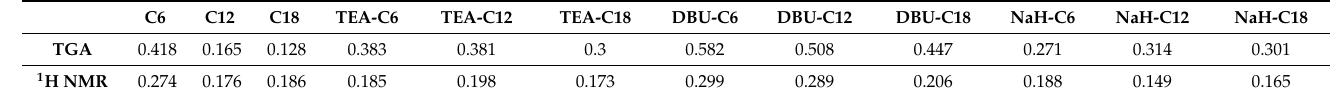
Table 2. Silica silanization grafting yield calculated from TGA and 1 H NMR (in mmol/g).